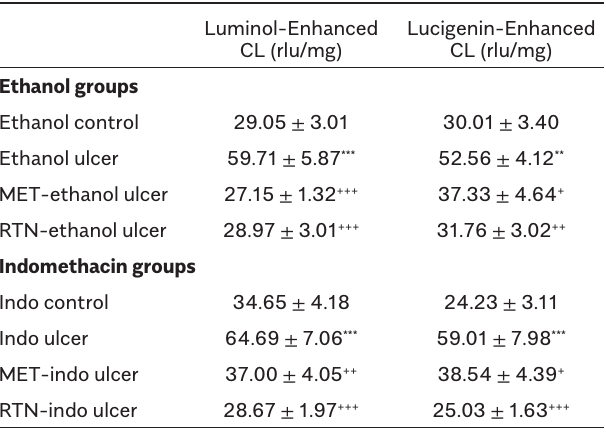
Table 3. Luminol- and Lucigenin-Enhanced CL Levels of the Gastric Samples in Experimental